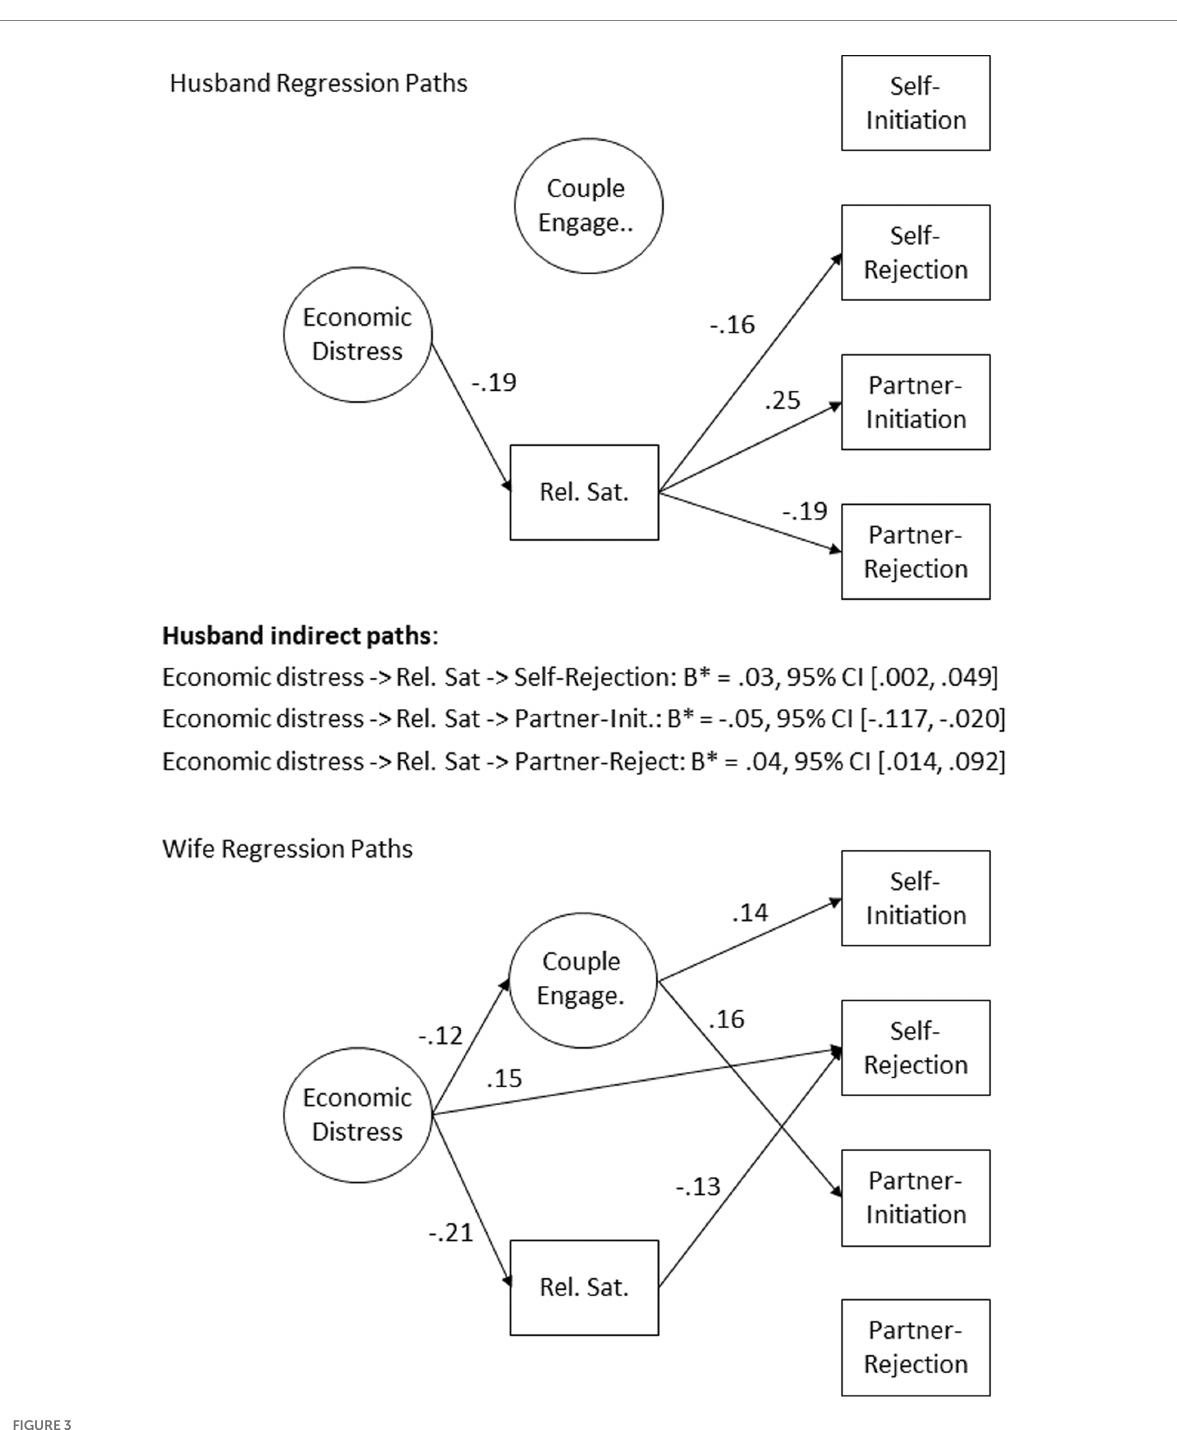
FIGURE 3 Estimated model (regression lines). Correlations and co-variates not shown. Standardized betas are reported for significant pathways. Non- significant paths not shown. 95% confidence intervals calculated using 5,000 bootstrapped samples. “Self-” indicates reports on self-behavior, and “partner-” indicates reports on partner